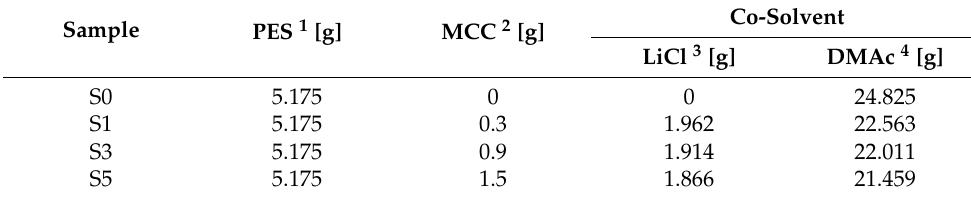
Table 1. Composition of the prepared casting solutions (total mass of casting solution = 30